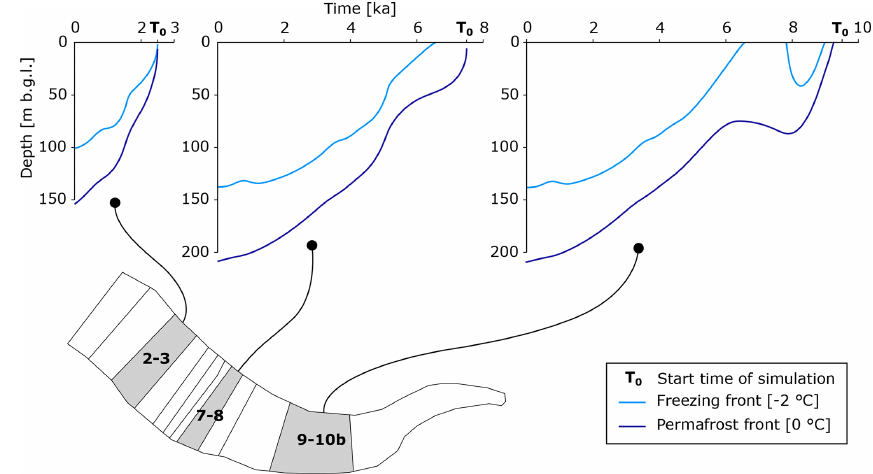
Figure 6. Development of simulated freezing front and permafrost front depths from zones 2–3, 7–8 and 9–10b of the model area (see Fig. 5). These simulation results are derived when using the intermediate porosity values (Table 2). Note that completely frozen ground does not establish permanently until ∼ 6 .